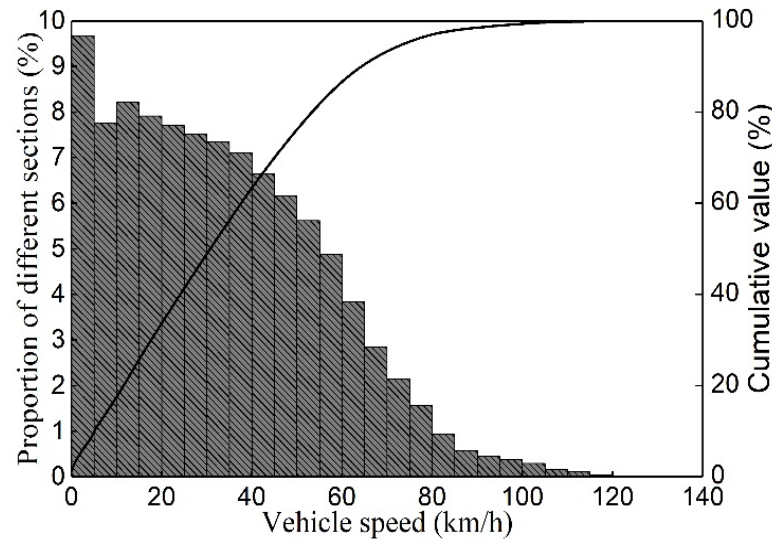
Figure 6. The distribution characteristic of the vehicle speed.